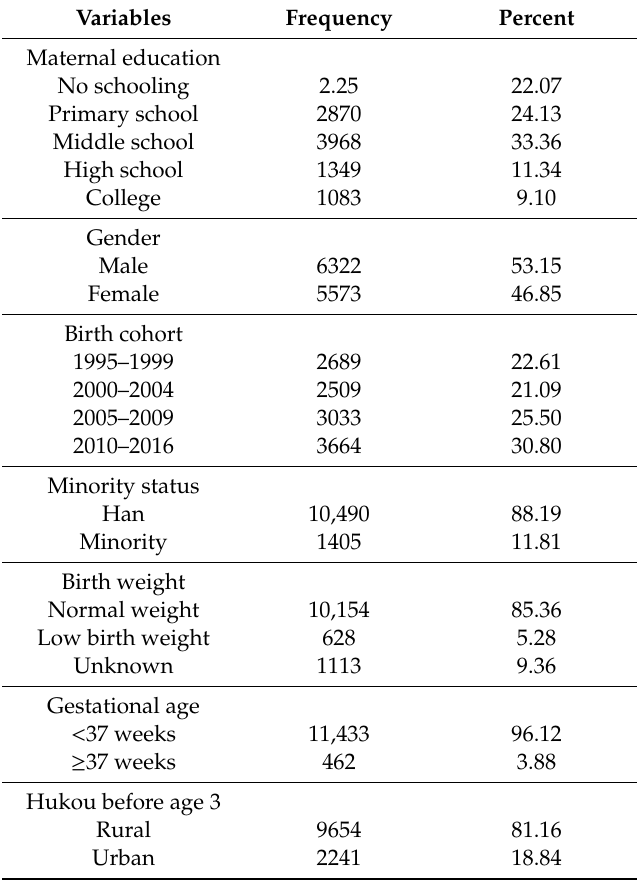
Table A1. Summary Statistics for All